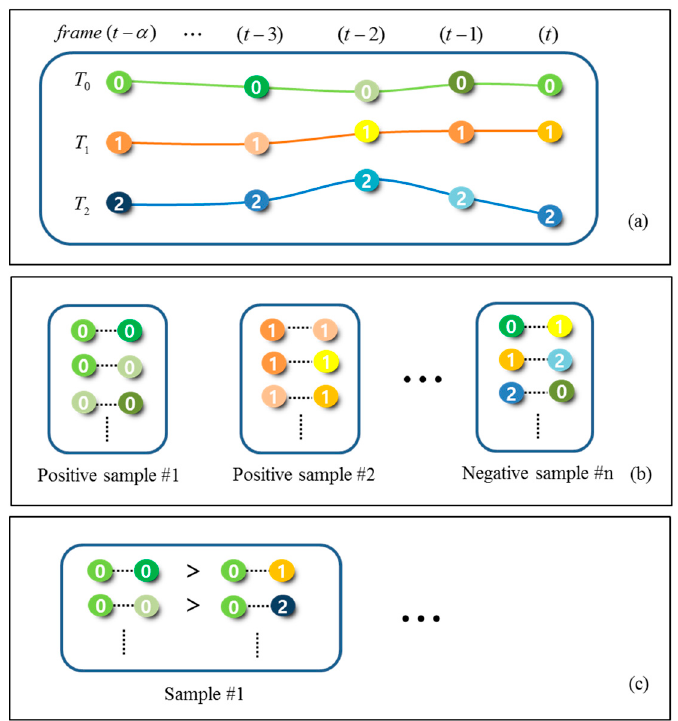
Figure 3. Training dataset: ( a ) example of tracklets; ( b ) composing binary training sets from ( a ); ( c ) composing ranking training sets from ( a ).